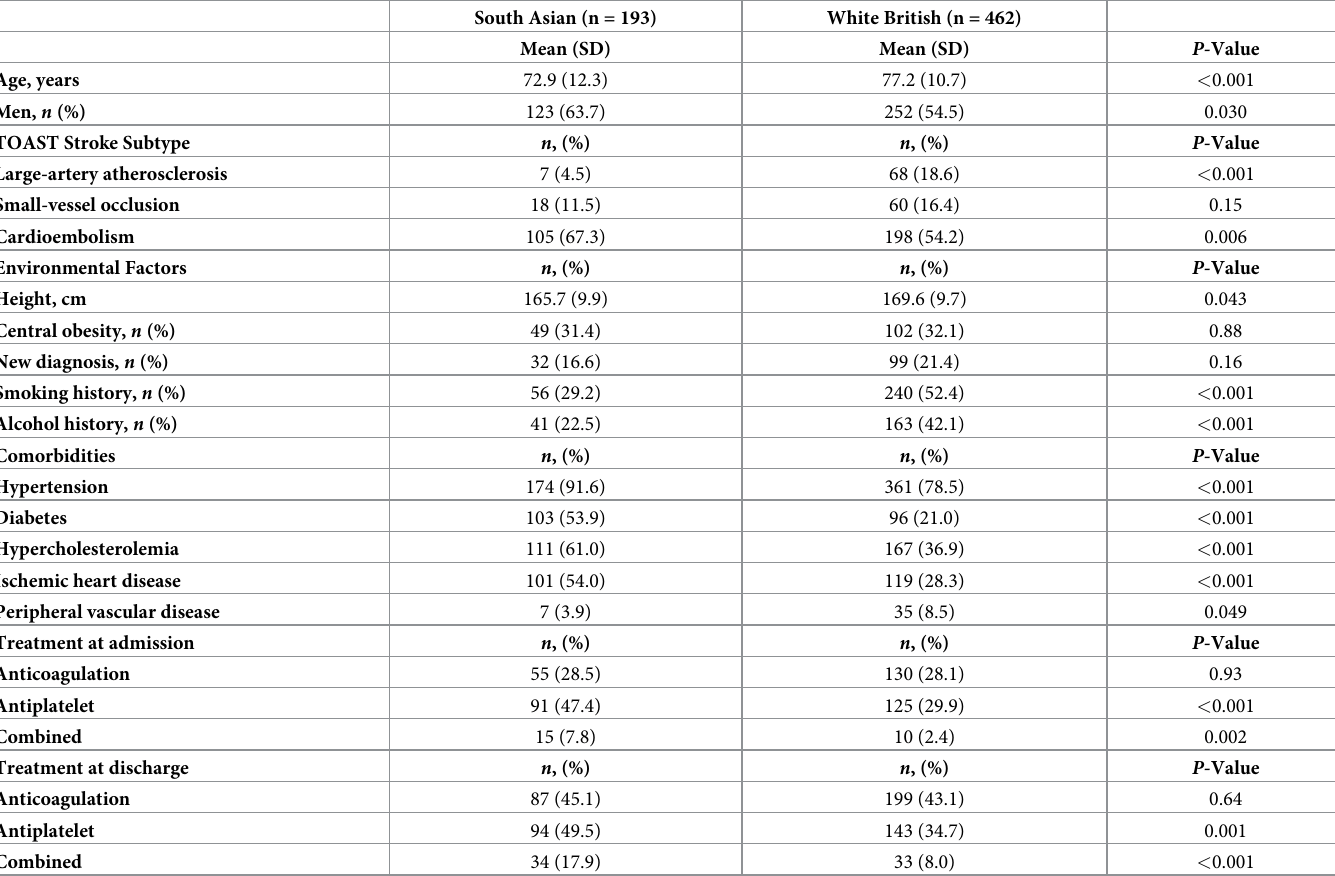
Table 2. Population characteristics with confirmed atrial fibrillation status stratified by